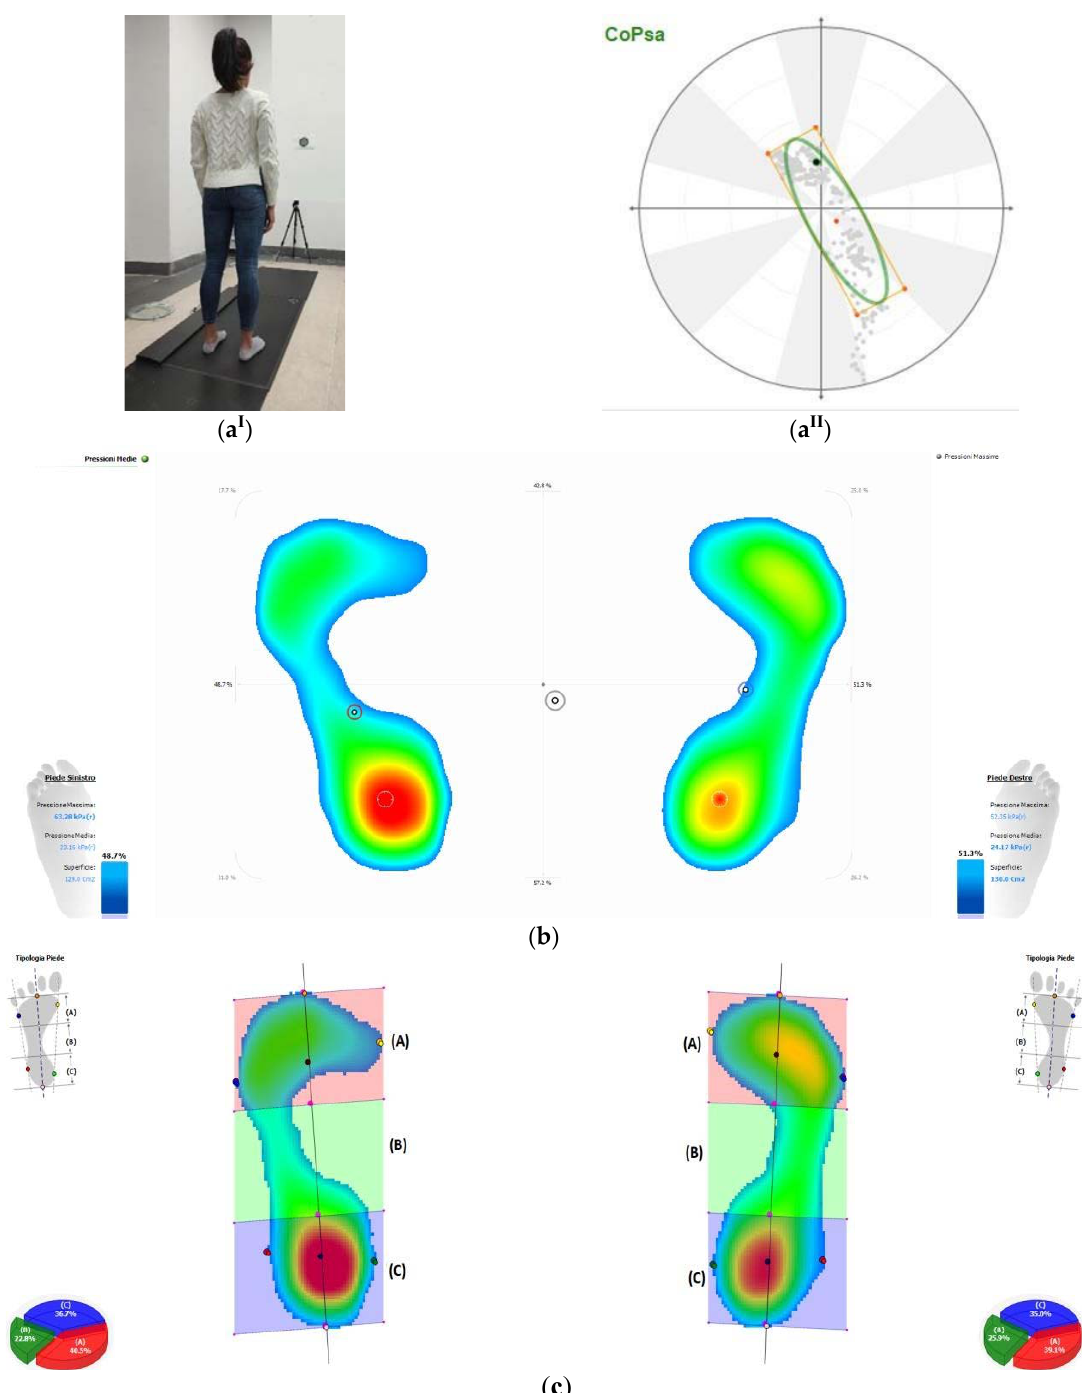
Figure 1. Subject in anatomical standing posture ( a I ), stabilometric ( a II ), and plantar pressure ( b , c ) parameters. ( a ) (CoPsa, center of pressure sway area); ( b ) (percentage of load distribution); ( c ) (division of foot in three equal regions: forefoot, A; midfoot, B; rearfoot, C).